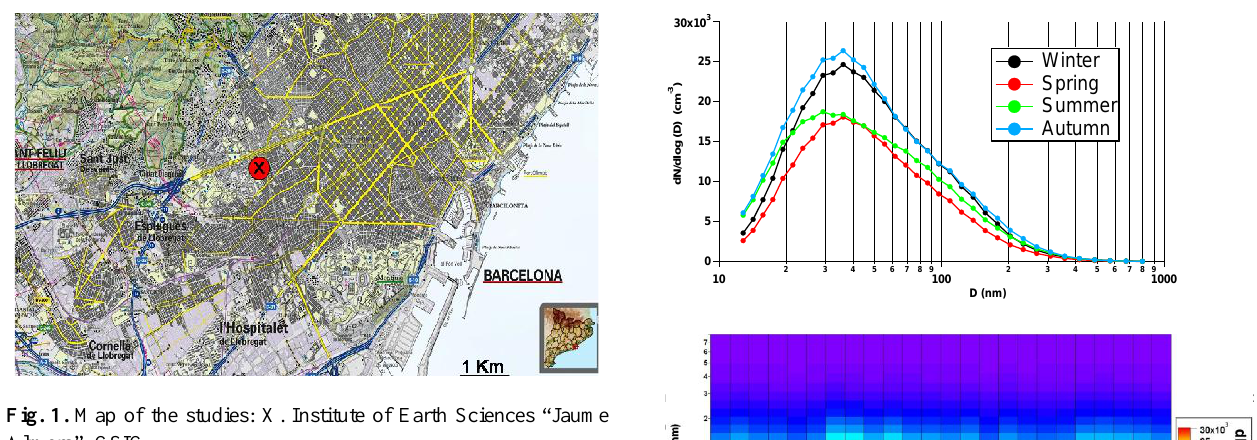
Figure 1 . Map of the studies: X. Institute of Earth Sciences ‘‘Jaume Almera’’, CSIC4 Fig. 1. Map of the studies: X. Institute of Earth Sciences “Jaume Almera”, CSIC